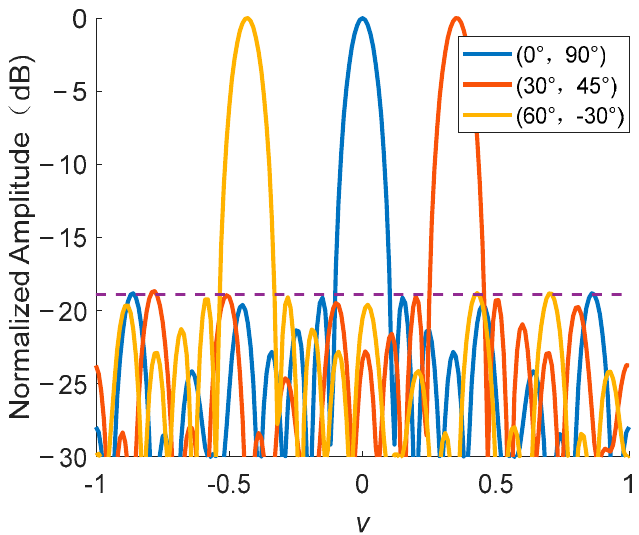
Figure 8. The v -cut of the radiation beam pattern diagram of the optimized array different main beam positions. 4.4. Simulation 4: Synthesis Results of Four Algorithms for Large Planar Thinned Arrays The array thinning effect may be affected by both array aperture and array filling rate. Table 3 records the PSLL and 3 dB bandwidth of the radiation beam pattern of thinned arrays optimized by each algorithm under different array apertures and filling rates. Each result is the mean value of five iterations running under the same simulation conditions. Table 3. Synthesis results obtained by four algorithms for large planar thinned